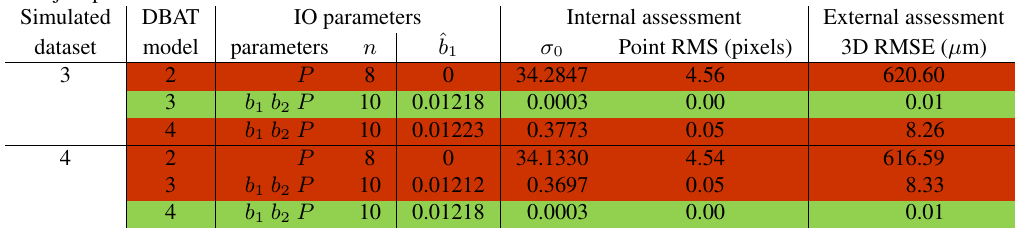
Table 1: Assessment of the analysis of the synthetic data sets. The IO parameters columns indicate what IO parameters and how many ( n ) were included in the estimation. The point RMS is the average residual over all image observations. The 3D RMSE is the average error over all object points. The ˆ b 1 column shows the estimated b 1 value.